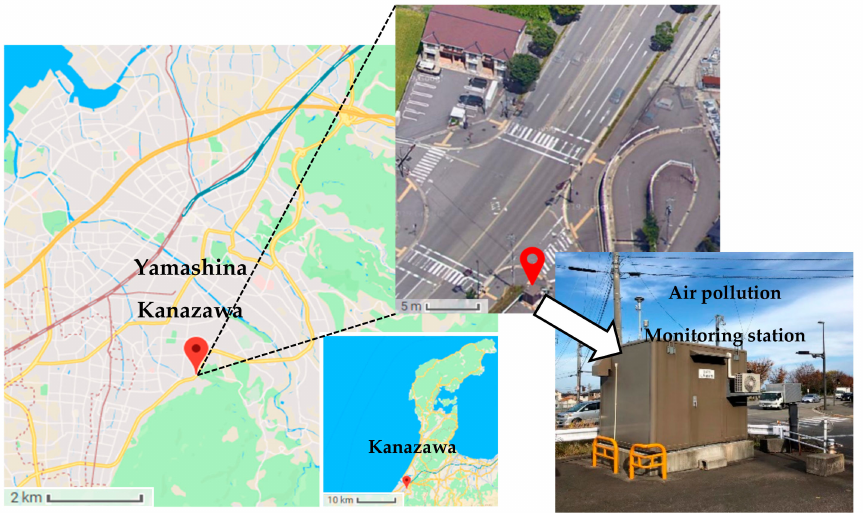
Figure 1. Sampling site at a roadside air pollution monitoring station in